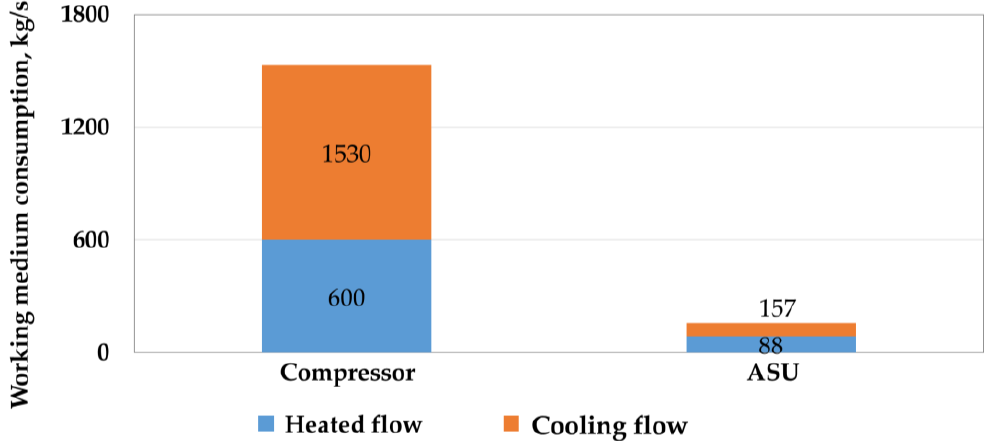
Figure 5. Comparison of the flow rate of the working and cooling flow in a multistage compressor and an air separation unit.